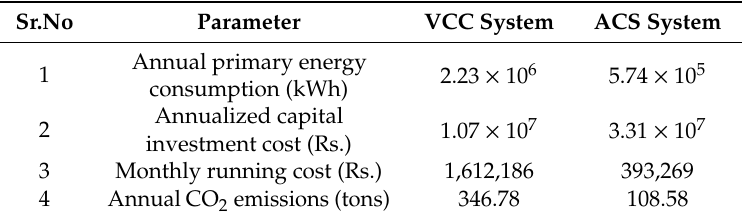
Table 6. 3E results of VCC and ACS